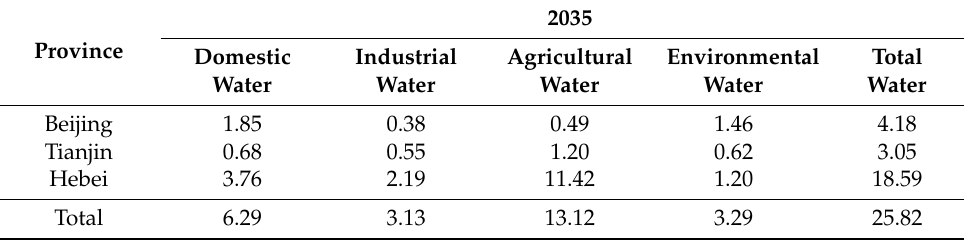
Table 1. Beijing–Tianjin–Hebei water demand in 2035 (the future research year) (billion m 3